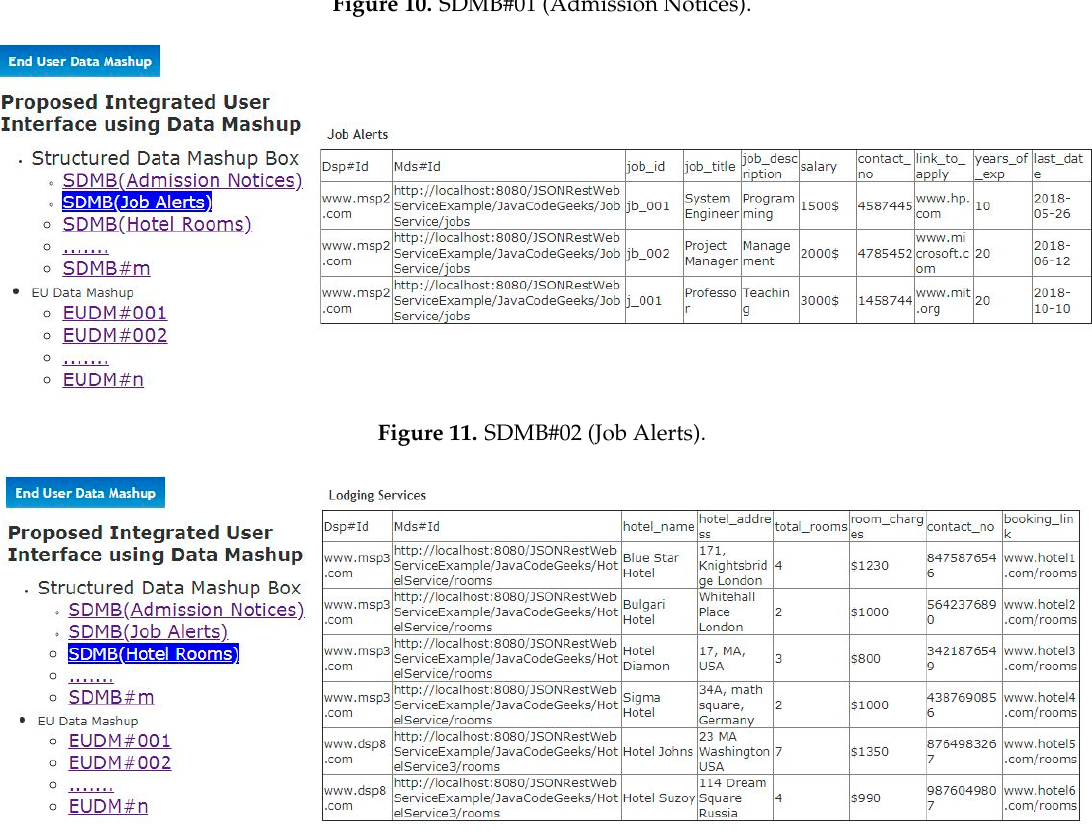
Figure 12. SDMB#03 (Lodging Services).